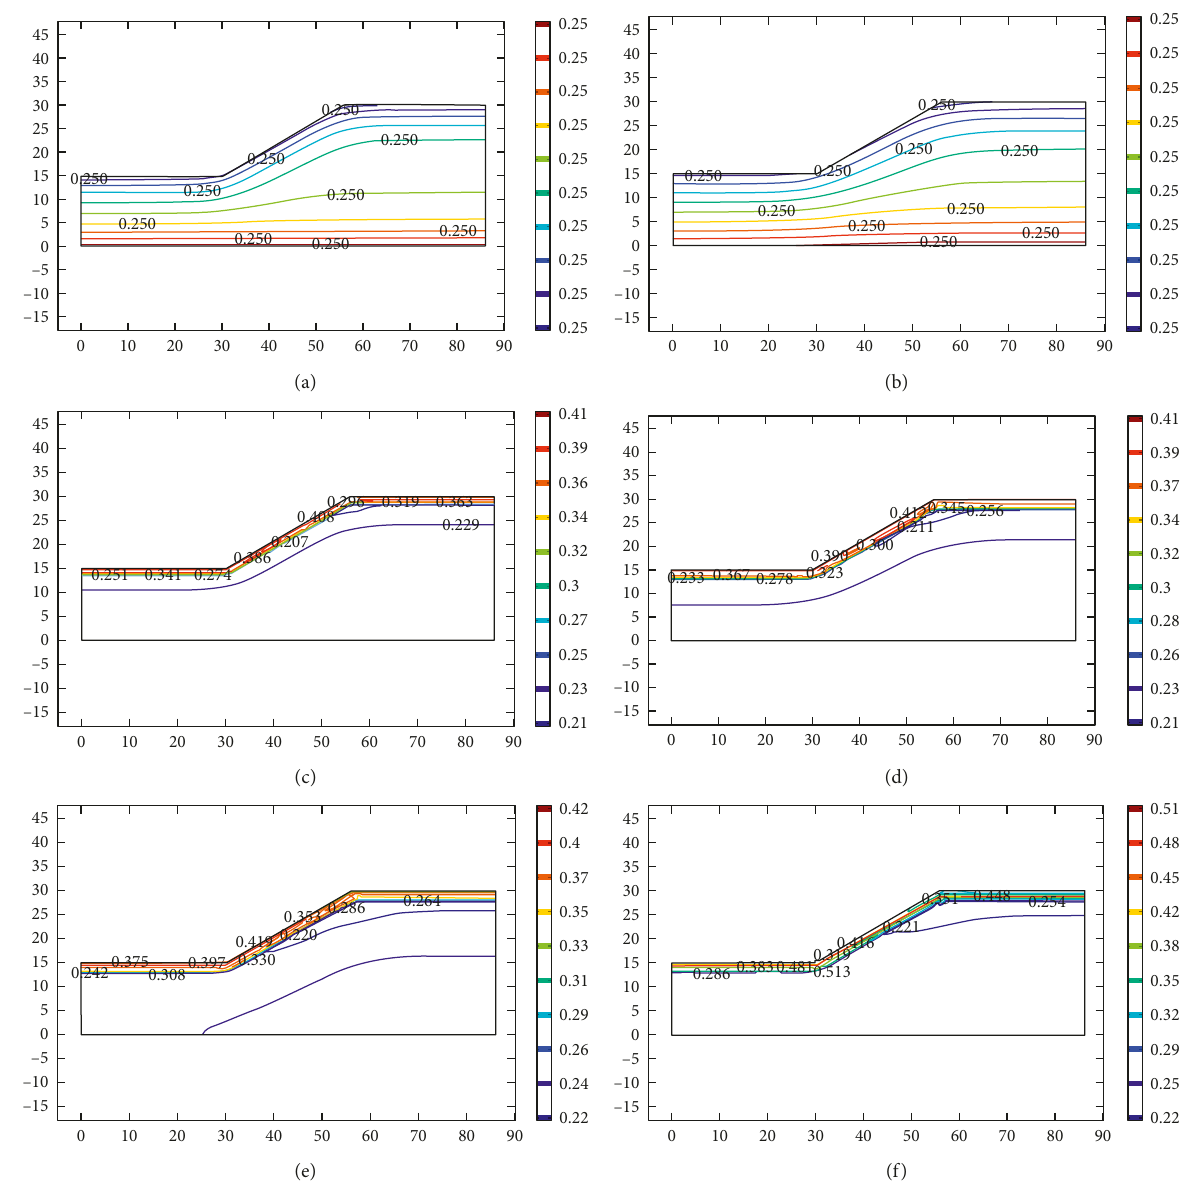
Figure 9: Distribution of the slope moisture isoline at different times. (a) t � 193d, T � 23.00 ° C; (b) t � 290d, T � 0.18 ° C; (c) t � 375d, T � − 18.30 ° C; (d) t � 430d, T � − 9.76 ° C; (e) t � 459 d, T � − 0.27 ° C; (f) t � 480 d, T � 7.14 °